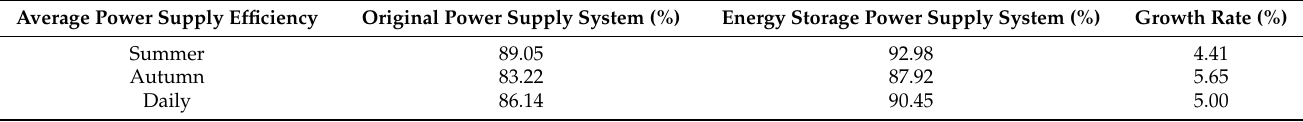
Table 6. The comparison of average power supply efficiency.